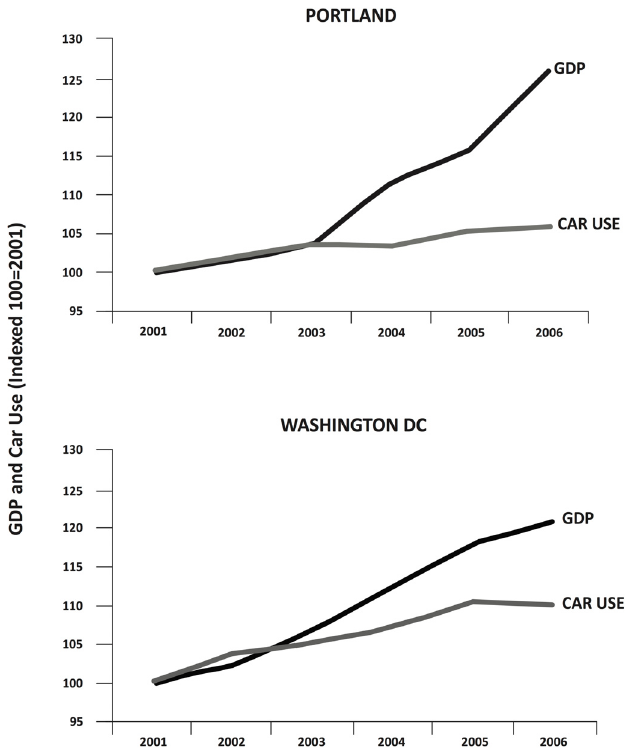
Fig. 2. Growth in decoupling car use from GDP in Washington, D.C. and Portland. Source : Authors own graphic based on data sourced from Kooshian and Winkelman